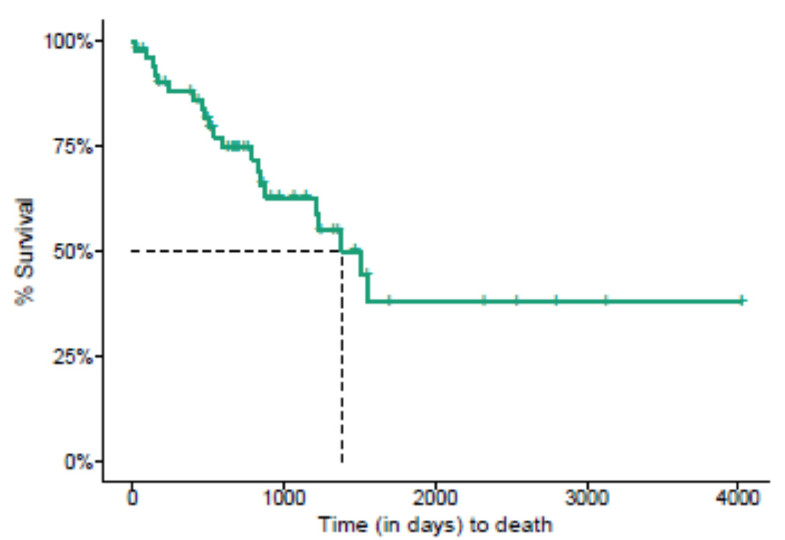
Figure 2. Kaplan–Meier survival analysis of the time to death in 53 patients with disseminated sporotrichosis at